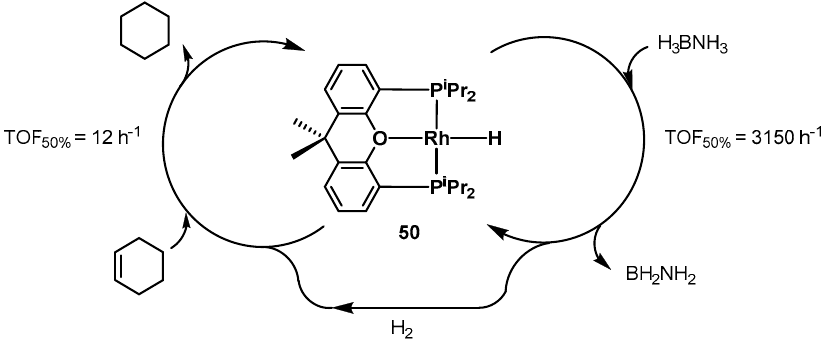
Figure 2. Iridium pincer catalysts investigated by Jensen for hydrogen release from pyrrolidine-based LOHCs [448], as well as dimethylamine–borane dehydrogenation by Belkova [449].